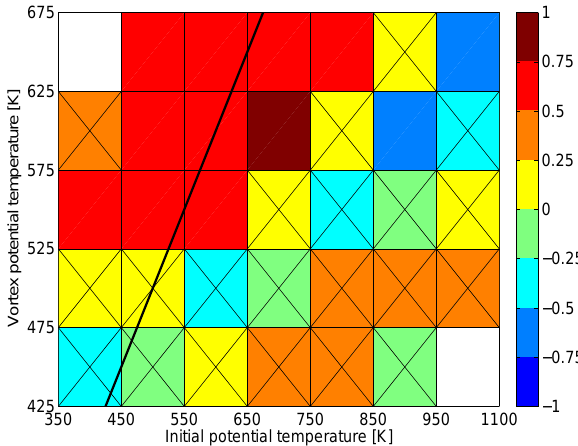
Fig. 10. Same as Fig. 9, but now the origin tracer is the fraction of vortex air in early winter originating from the potential temperature interval given at the horizontal axis on 1 September. Correlation coefficients not significant at the 95% level are crossed out. The black line is the line of zero Lagrangian subsidence. Time series are